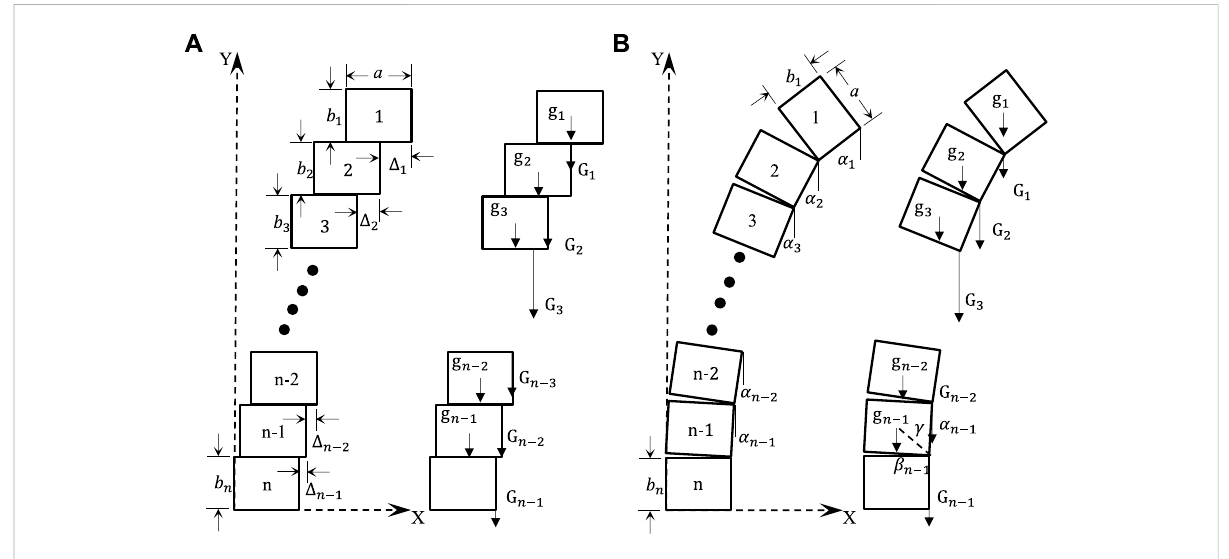
FIGURE 14 Translational and rotational motion patterns of the mechanical mechanisms. (A) Translational motion pattern. (B) Rotational motion